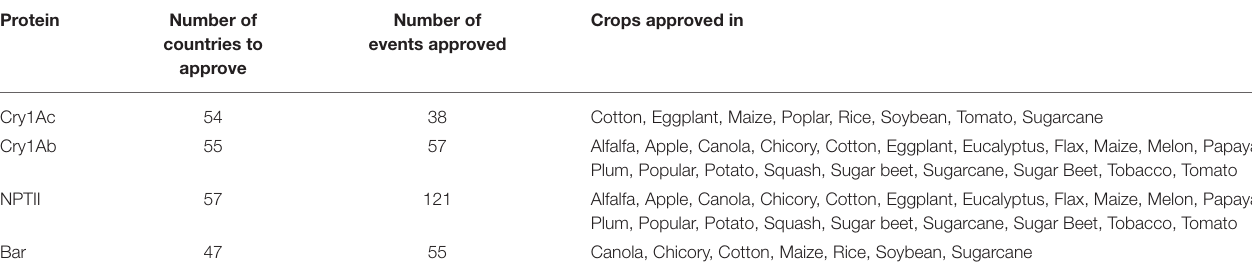
Acetyltransferase (PAT) enzyme) “Residues of the Phosphinothricin Acetyltransferase (PAT) enzyme are exempt from the requirement of a tolerance when used as plant-incorporated protectant inert ingredients in all food commodities.” → 40 CFR 174.522